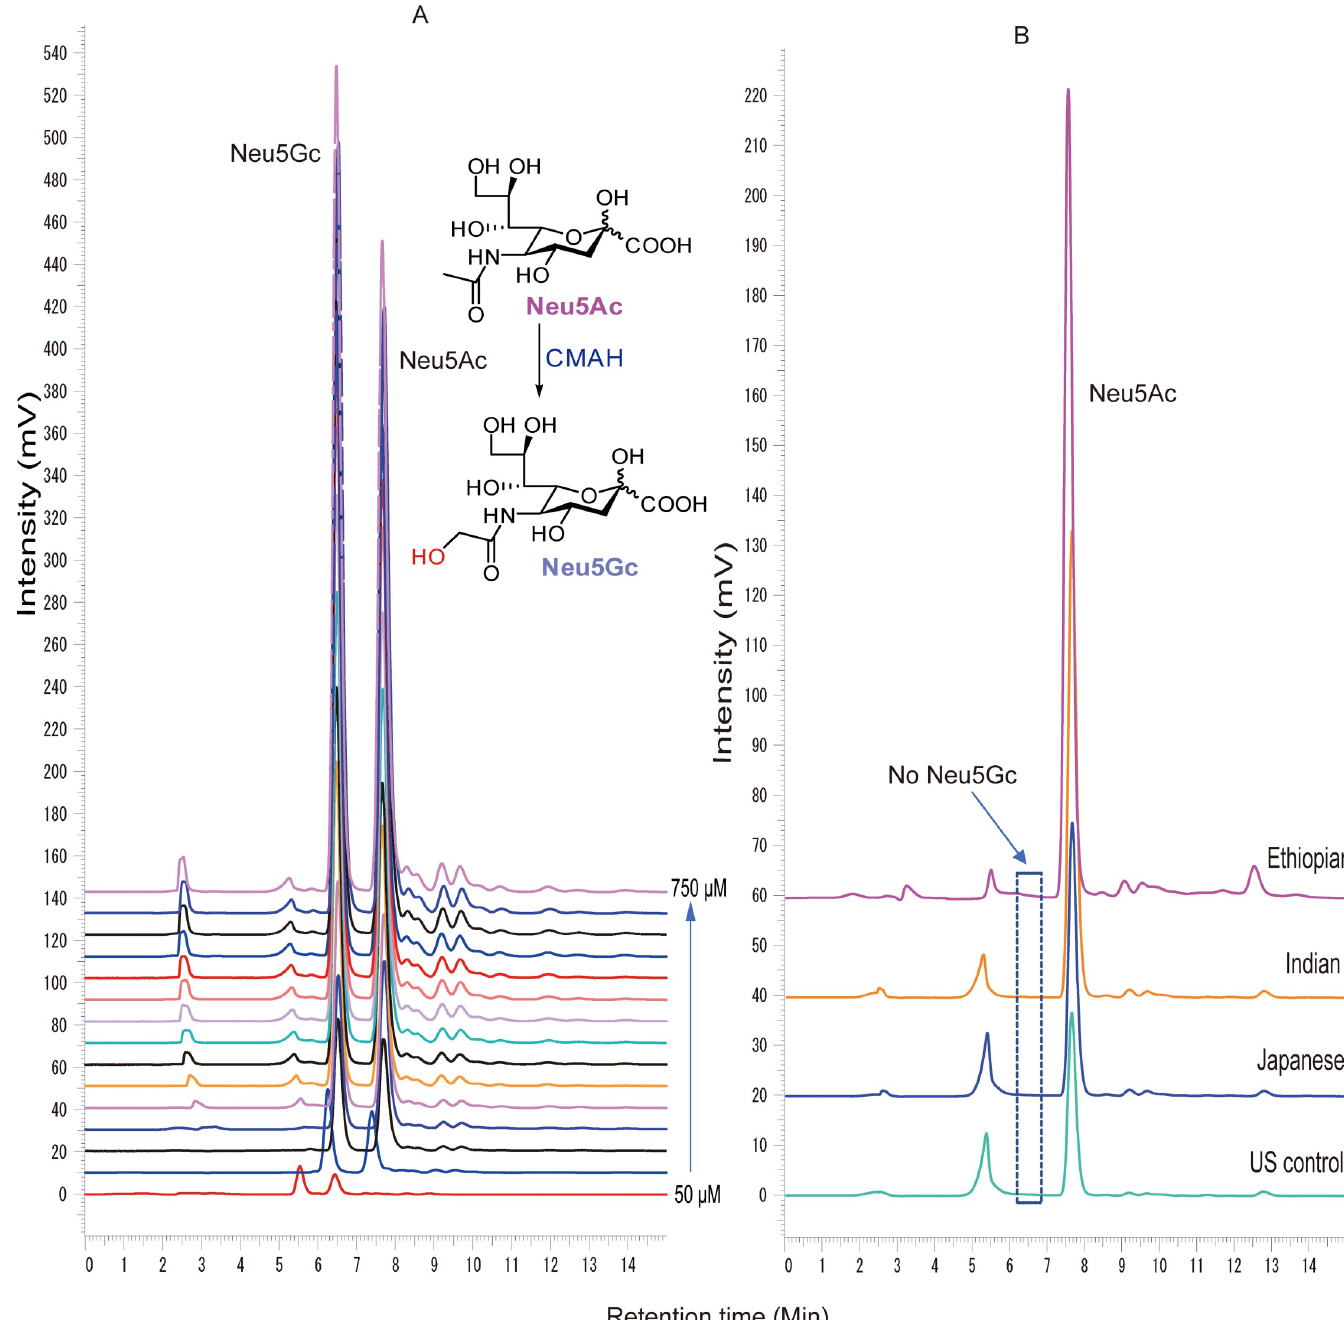
Fig 8. HPLC chromatogram showing quantitation of free sialic acids. A ) standard Neu5Gc and standard Neu5Ac, B ) Neu5Ac derived from captured serum N - glycans. Neu5Ac : N- acetylneuraminic acid, Neu5Gc : N- glycolylneuraminic acid. CMAH : Cytidine monophosphate N -acetylneuraminic acid hydroxylase (enzyme that catalyzes conversion of Neu5Ac to